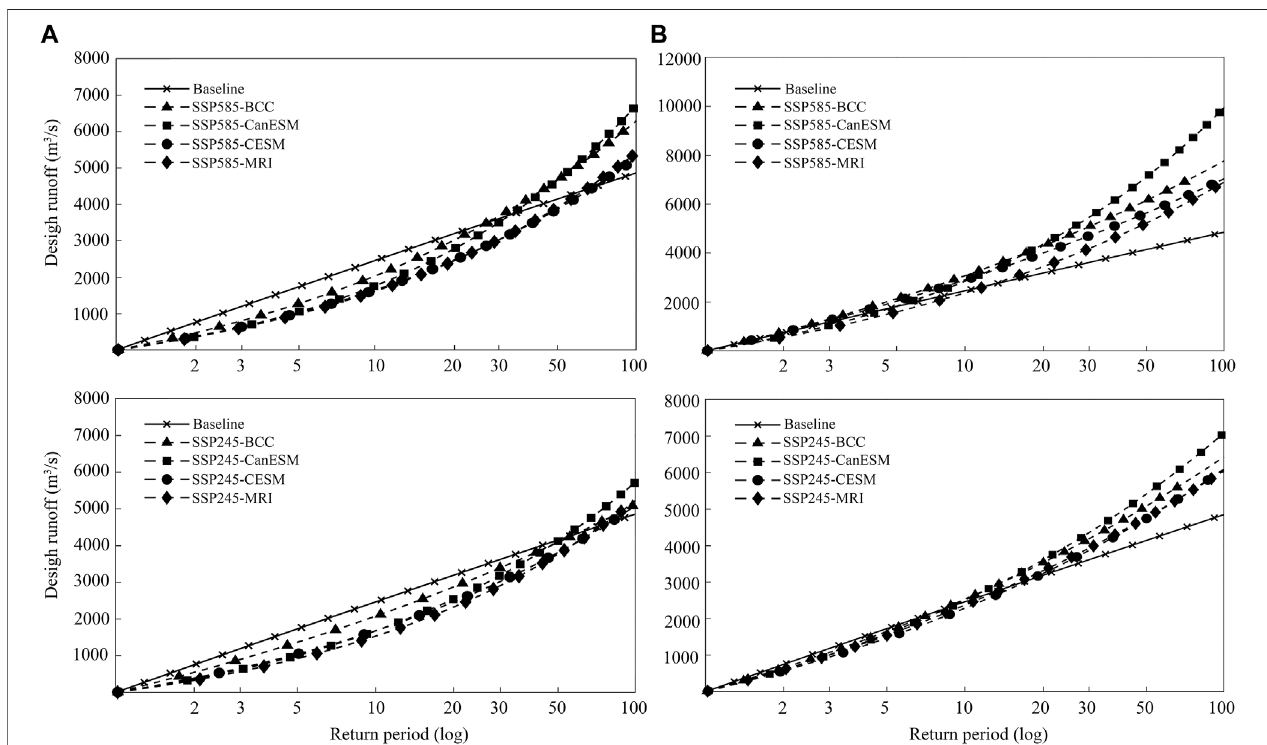
FIGURE 9 | Design fl oods of different return periods for various GCMs under SSP245 (bottom) and SSP585 (top) scenarios during two future periods 2050s (A) and 2080s (B) .